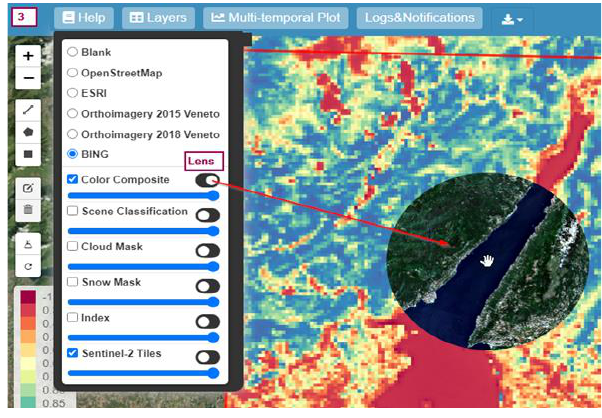
Figure 4. The result from rendering the chosen index raster (see Figure 3). It is possible to overlap another layer for interactive visualization via the lens